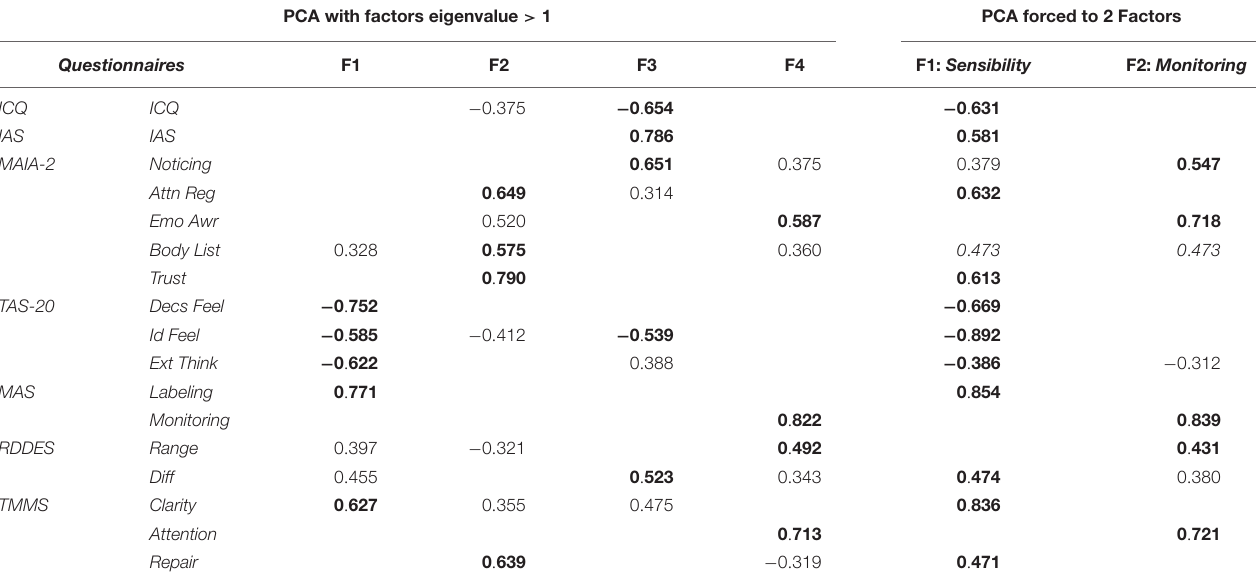
TABLE 2 | Principal Component Analysis (PCA) on interoception and emotional conceptualization scales. PCA with factors eigenvalue > 1 PCA forced to 2 Factors